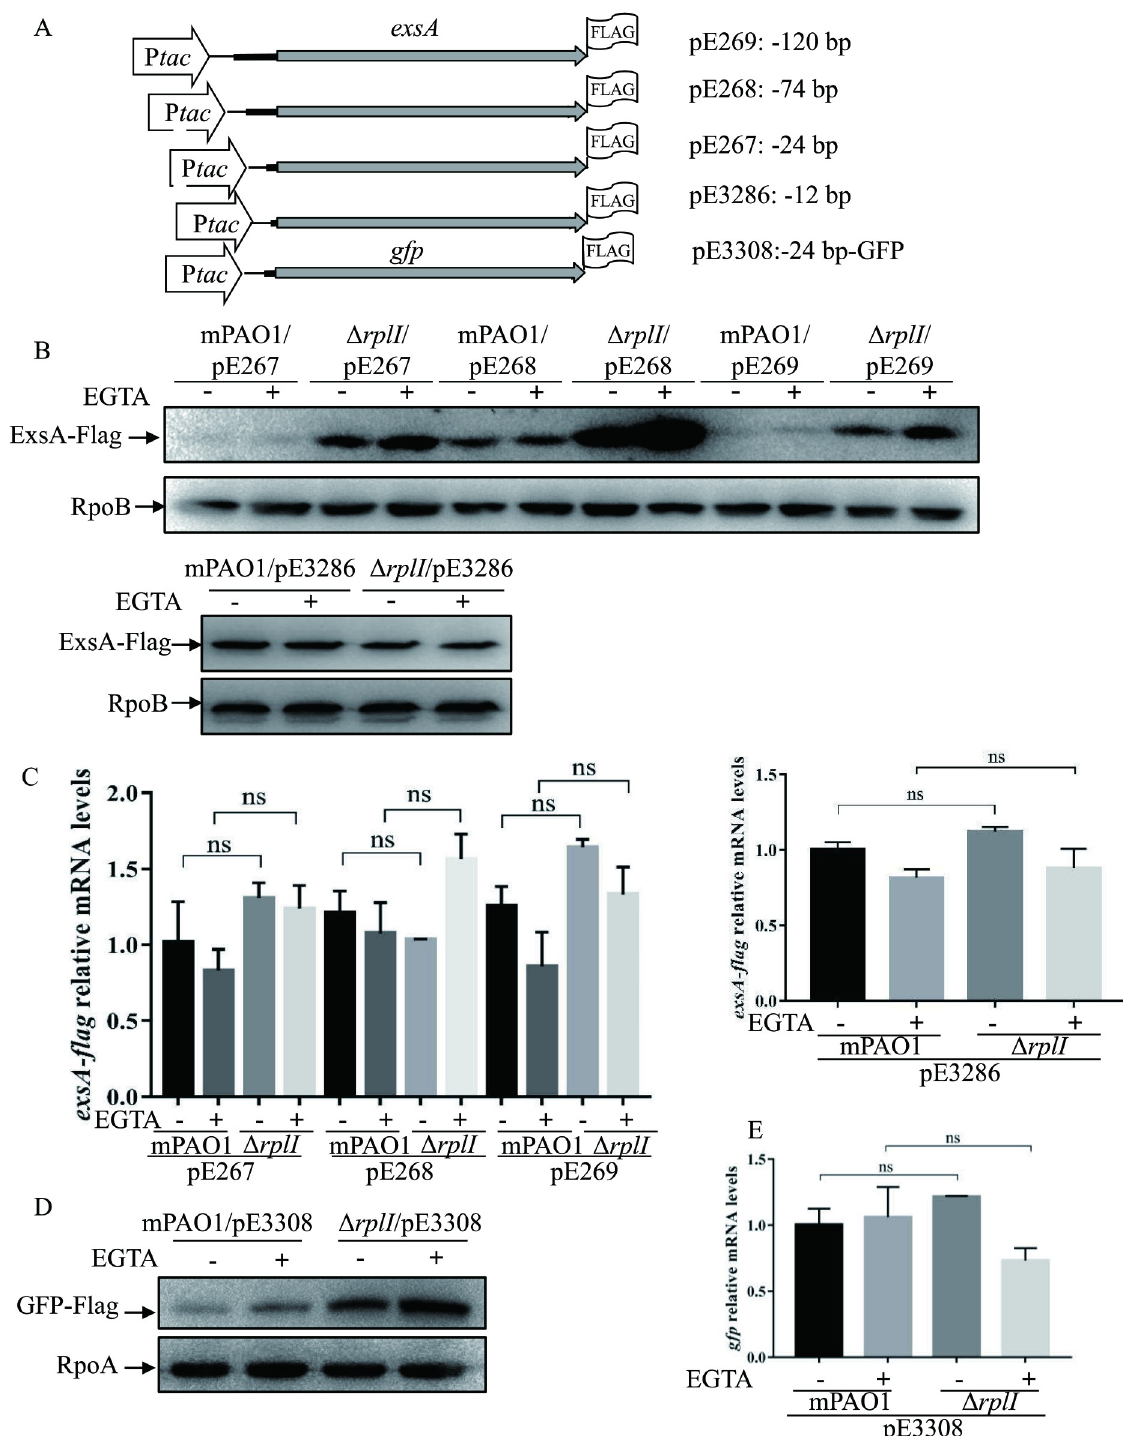
Fig 4. RplI-dependent repression of ExsA translation requires a 24 bp 5’ untranslated region of exsA . (A) Constructs of exsA -Flag and gfp -Flag. (B and D) Amounts of ExsA-Flag or GFP-Flag in the indicated strains. Overnight-cultured mPAO1 and Δ rplI containing the indicated constructs were diluted 1:50 into LB medium, grown to an OD 600 of 1.0 with (+) or without (-) 5 mM EGTA and collected by centrifugation. Samples from equivalent numbers of bacterial cells were loaded onto an SDS-PAGE gel and probed with an anti-Flag, an anti- RpoB antibody or an anti-RpoA antibody. The data shown represent the results from three independent experiments. (C and E) exsA-flag (C) or gfp (E) mRNA levels in mPAO1 and Δ rplI containing pE267, pE268, pE269 or pE3286 (C) or pE3308 (E). Total RNA was isolated under